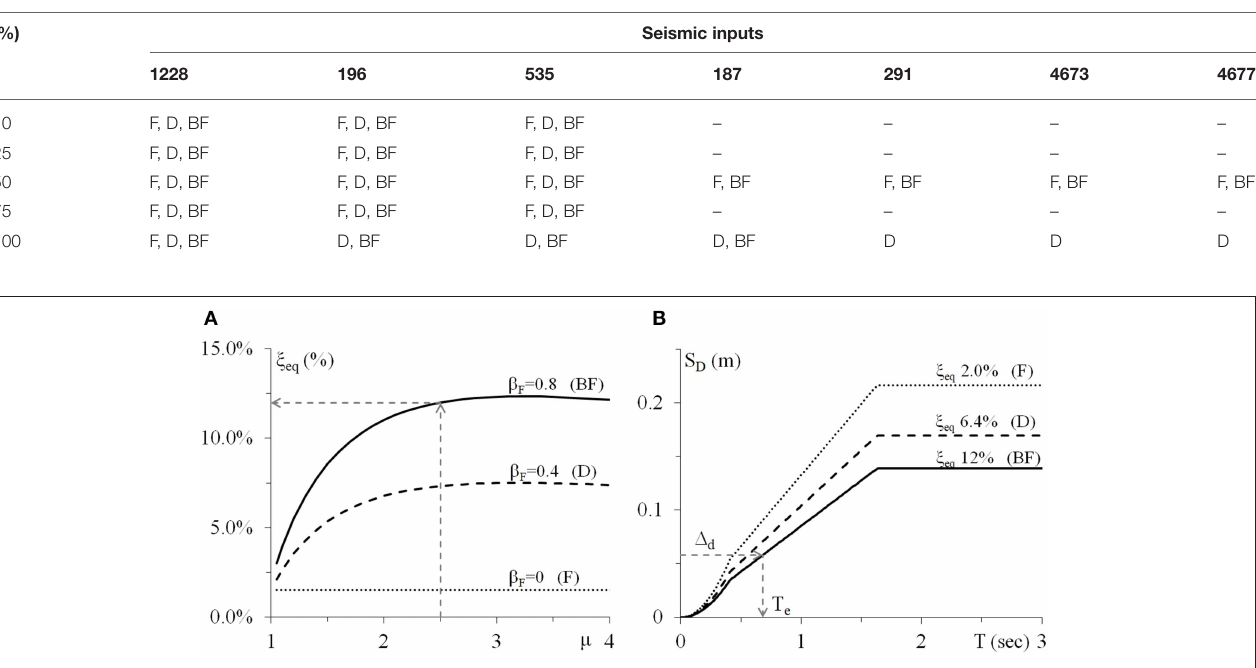
of the design displacement 1 u = 58 mm or drift = θ d